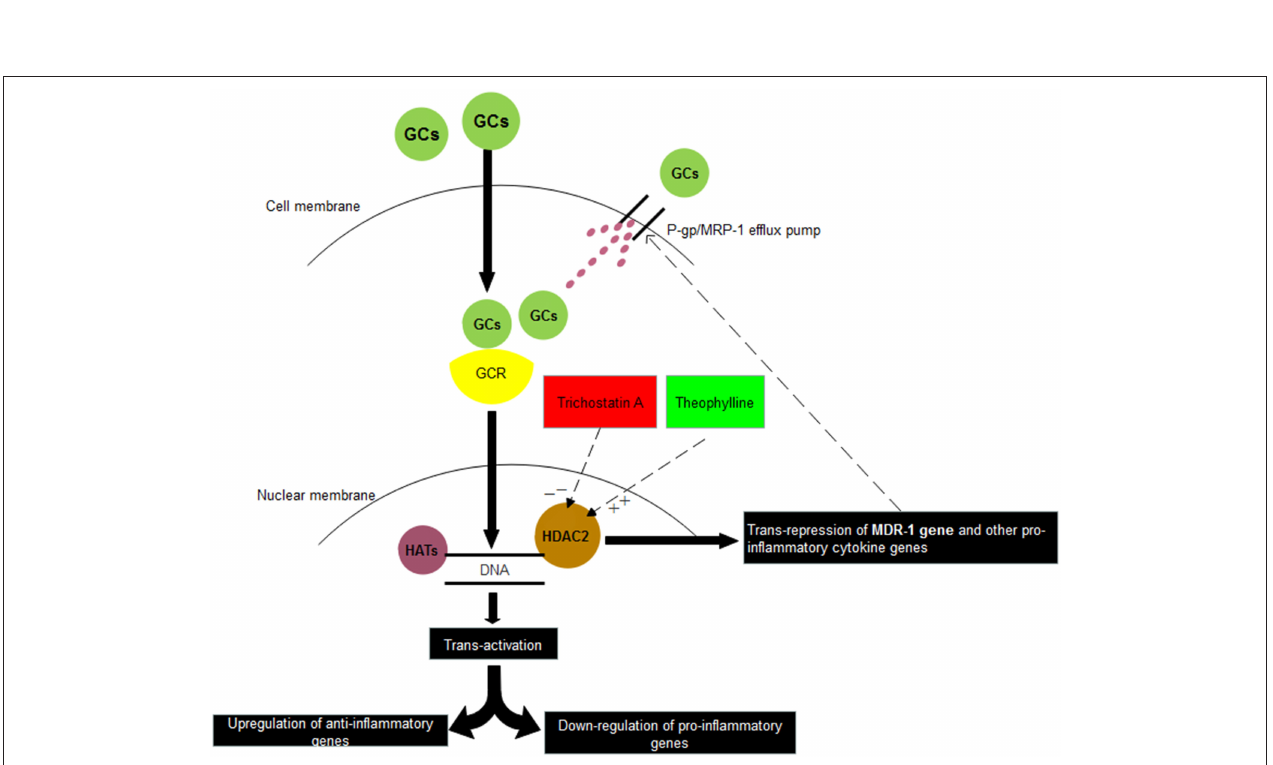
FIGURE 4 | Relationship between corticosteroids and HDAC2. Glucocorticoids (GCs) on entering into the cell binds with Glucocorticoid receptor (GCR) present in the cytosol. Thereafter, GC-GCR complex enters inside the nucleus and binds to Glucocorticoid Receptor Elements (GREs) present on the promotor regions of various genes. Depending upon its binding to either positive GREs or negative GREs, transactivation or trans-repression of genes is resulted. In another trans- repression mechanism, GC-GCR complex induces the recruitment of HDAC2, which binds to GREs of certain genes and results in deacetylation of MDR-1 gene, other pro-inflammatory genes. Thus, inhibitors of HDAC2 (Trichostatin A) may suppress the steroid response whereas stimulators of HDAC2 (Theophylline) may increase the steroid response. HAT: Histone Acetylases, HDAC2: Histone Deacetylases 2.